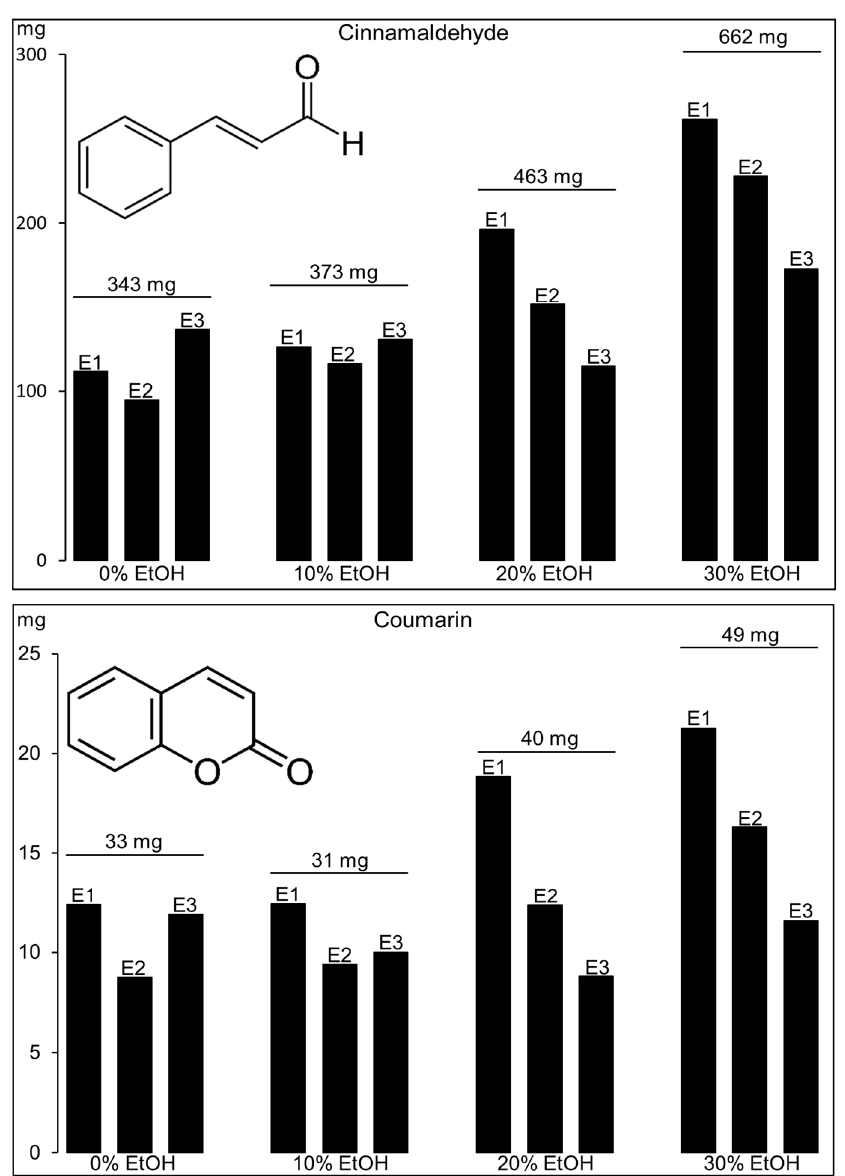
Figure 3. Amount (mg) of cinnamaldehyde and coumarin from the first (E1), second (E2), and third (E3) extracts obtained by PHWE of 20 g (each) of Cinnamomum cassia bark. The total amount extracted (E1 + E2 + E3) from three consecutive PHWE is at the top of each extraction solution. Analysis was by MEKC, as described in the Materials and Methods Section.